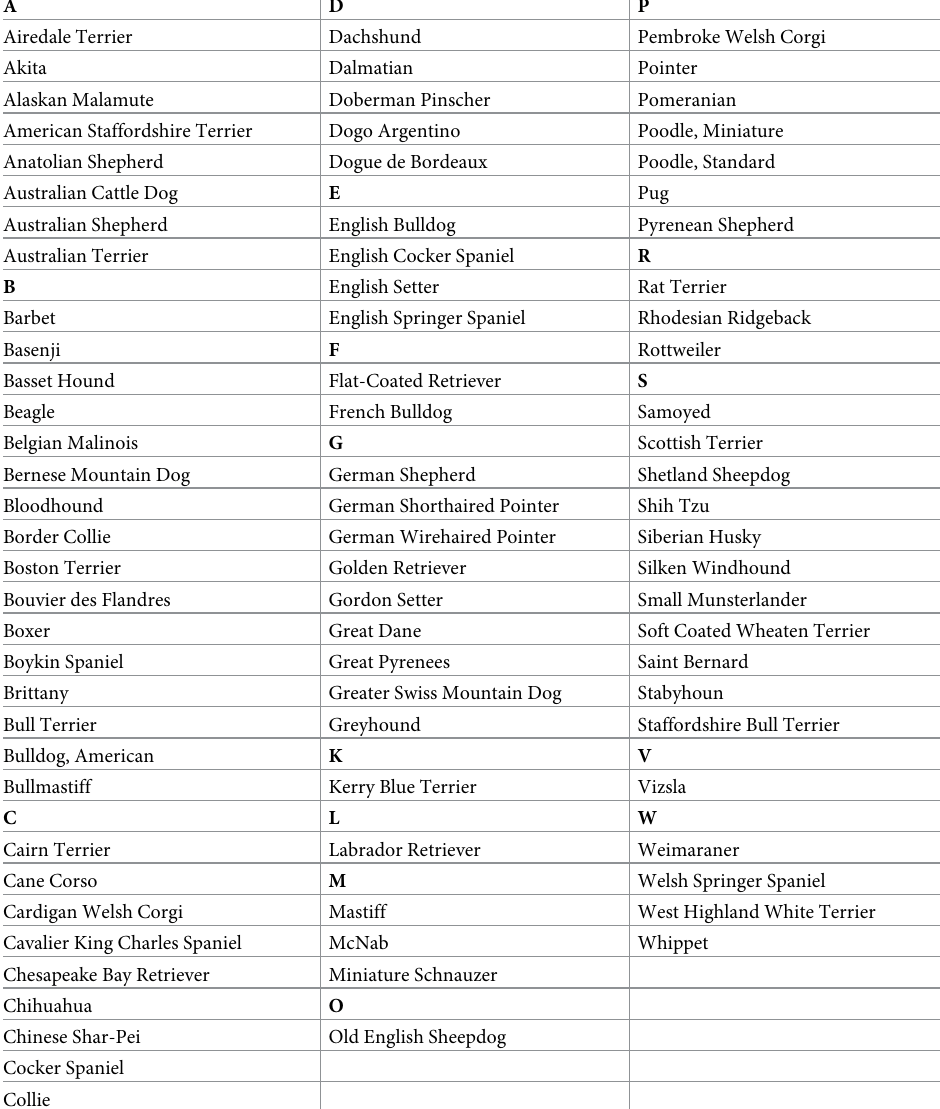
Table 3. List of 85 dog breeds represented in the training and testing sets of the CANDiD study.